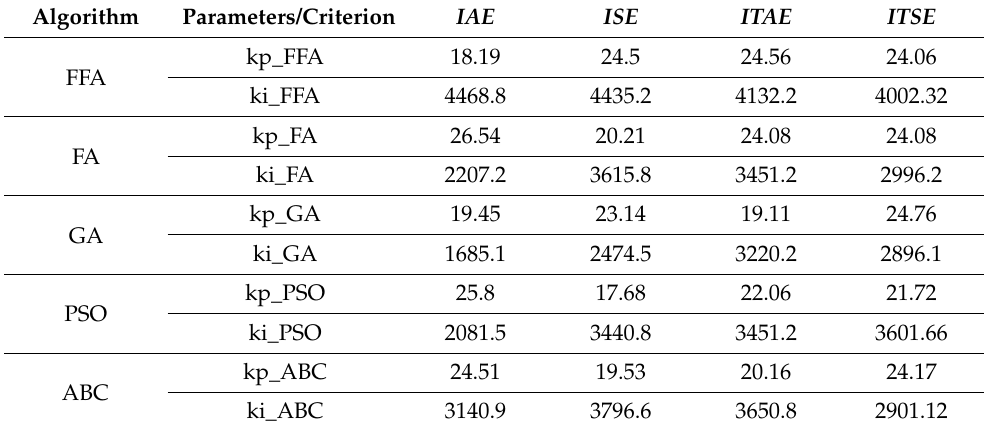
Table 7. kp, ki parameters obtained by various objective functions and various algorithms.